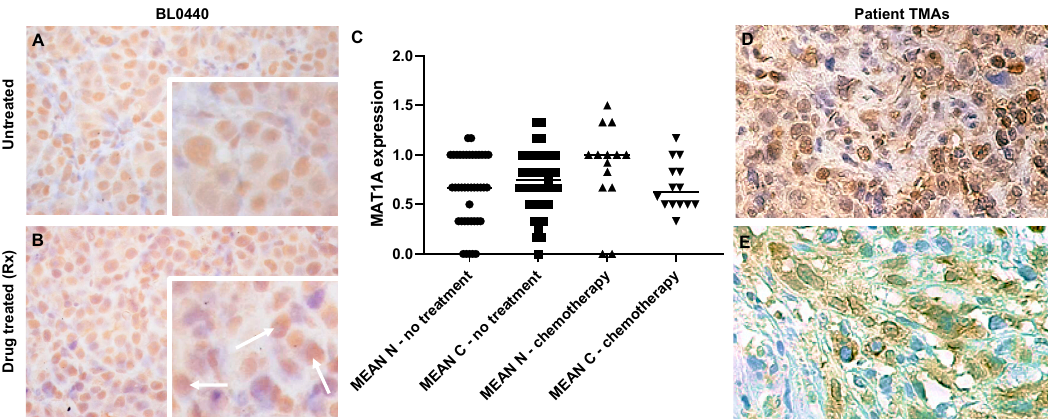
Figure 3. MAT1A protein levels increase in drug relapsed PDX and clinical patient tumors. MAT1A protein expression was examined by immunohistochemical (IHC) analysis in ( A ) non-drug relapsed and ( B ) drug relapsed BL0440 tumors. Images taken at 40 × magnification, insets are enlargements of image shown, white arrows highlighting regions of enhanced MAT1A abundance in chemotherapy treated tumors. ( C ) MAT1A expression quantification across patient tissue microarrays (TMAs) (n, nuclear; c, cytoplasmic). ( D , E ) Evaluation of TMA of bladder cancer samples obtained during cystectomy. IHC analysis includes MAT1A protein stained with labeled streptavidin biotin (LSAB) and counterstained with hematoxylin. ( D ) Sample showing nuclear and cytoplasmic localization of MAT1A from male patient receiving six cycles of chemotherapy which included gemcitabine; ( E ) sample showing only cytoplasmic MAT1A localization from male patient receiving Bacillus Calmette- Guerin (BCG).